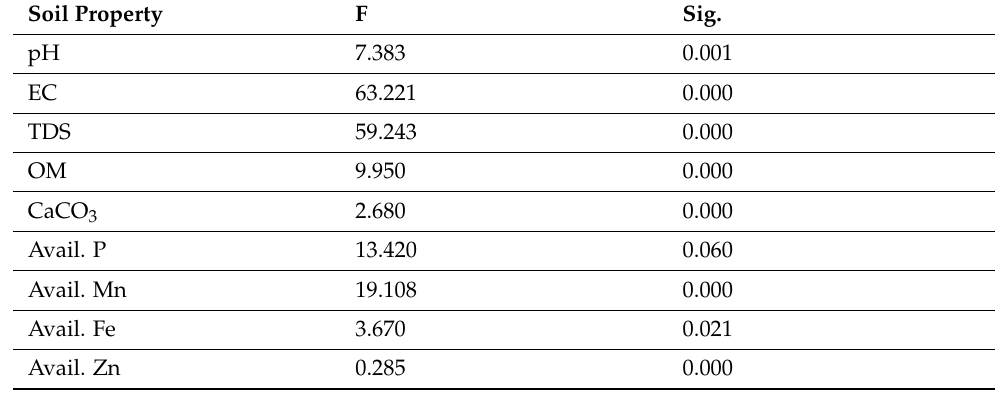
Table 2. One way analysis of variance of soil properties affected by microplastics and biochar.